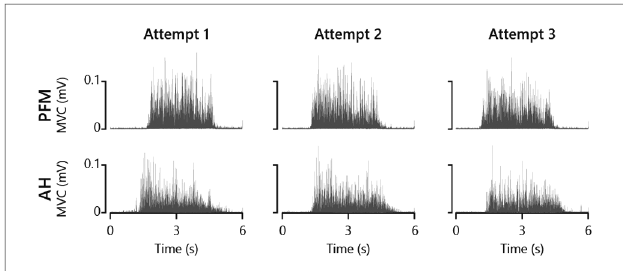
FIGURE 2 Attempted maximal voluntary contractions (MVC) of PFM and AH from an exemplary